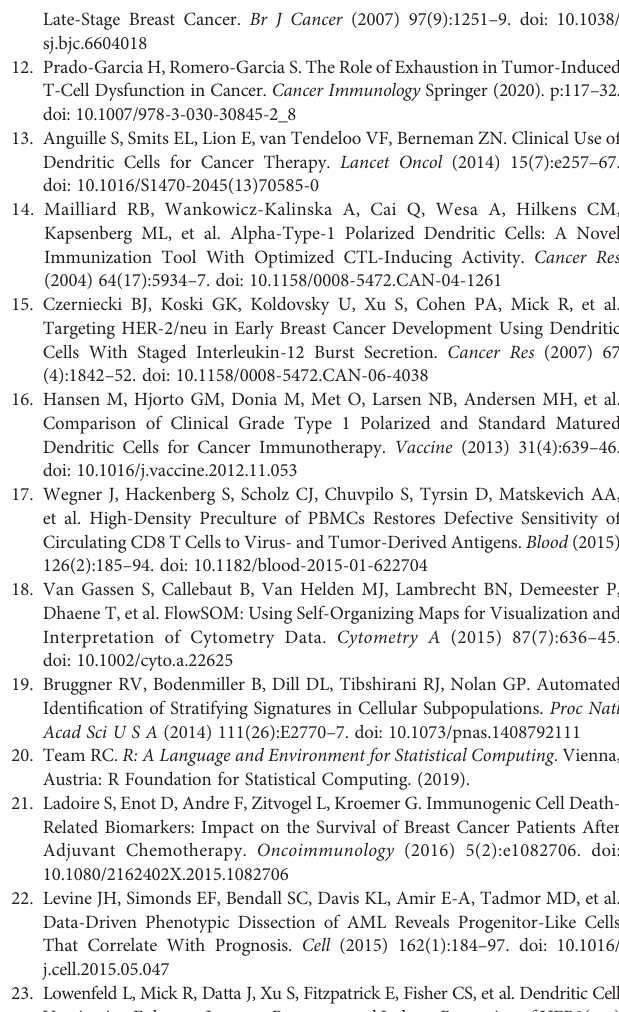
Supplementary Figure 1 | Schematic model of multivariate analysis of fl ow cytometry data. Work fl ow for the analysis of fl ow cytometry data from acquisition ( fi le in FCS format) and manual analysis. For automated analysis concatenated samples were dimensionality reduced using tSNE. Cluster generation heat maps and hierarchical tree were done using FlowSOM plugin in FlowJo (BD). For CITRUS